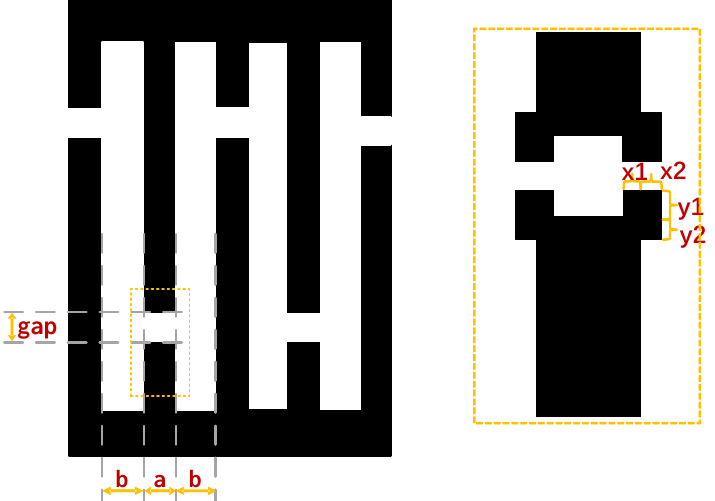
Figure 7. OPC compensation for adding patterns to photomasks.